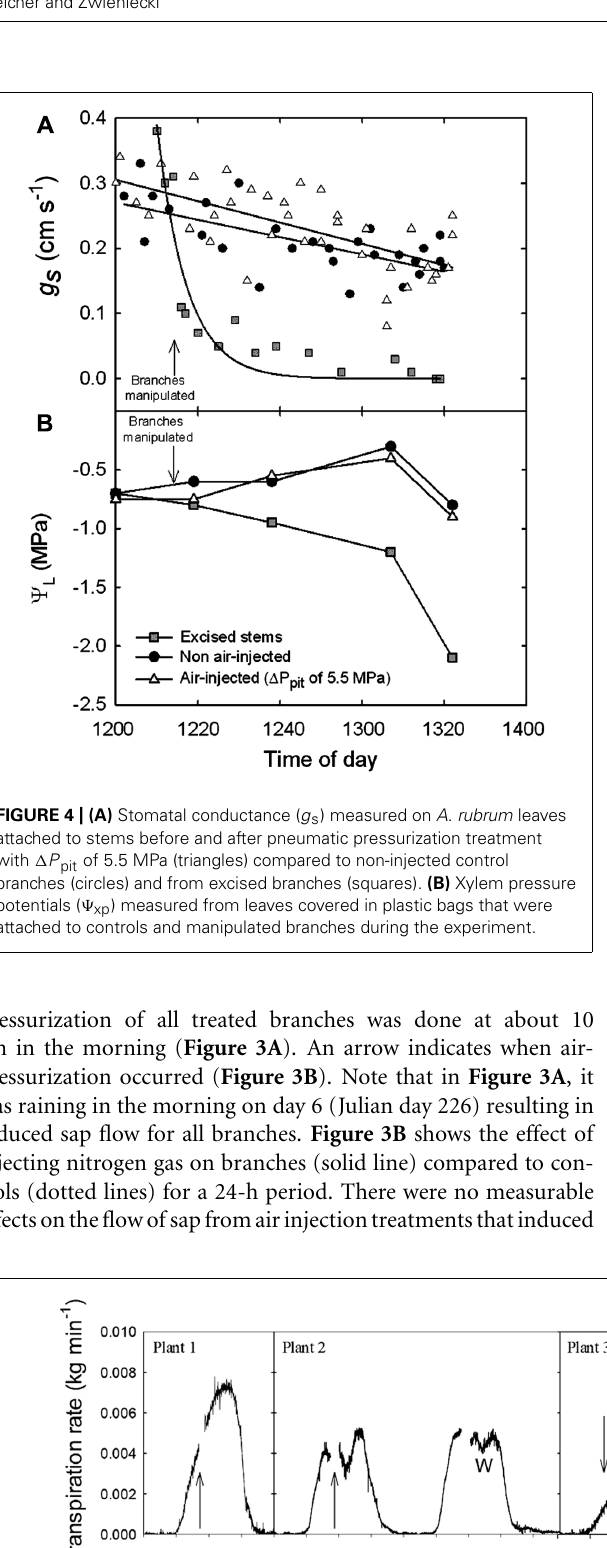
FIGURE 5 |Whole plant transpiration of potted plants of 2-year-old A. rubrum trees . Data were measured using an analytical balance before and after injection of gas that created (cid:2) P pit values of 5.5 MPa in the main